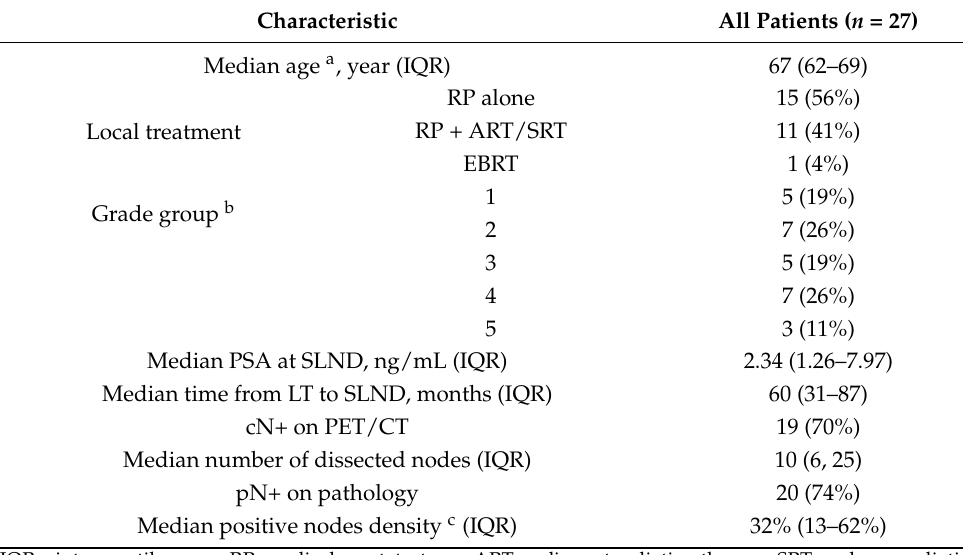
Table 1. Baseline patient characteristics.